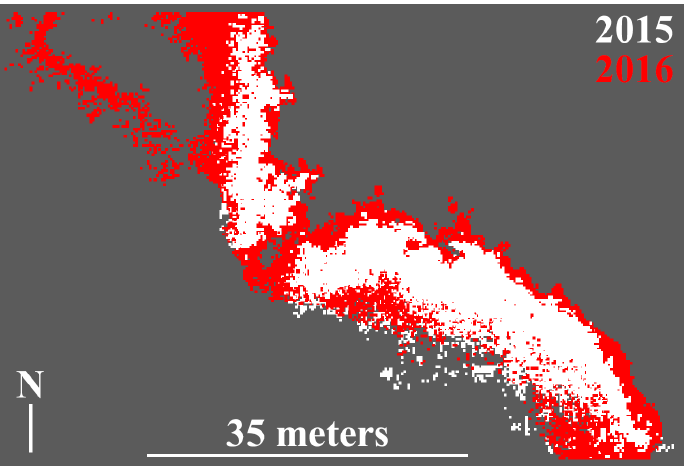
Figure 16. A 5 m wide slice (bottom) of the 2015 airborne lidar returns, colored according to the height thresholds used in the classification model. A 0.4 m height bin of the 2015 airborne lidar returns (inset, top right) shows the narrow and conserved height ranges of the saltmarsh components.